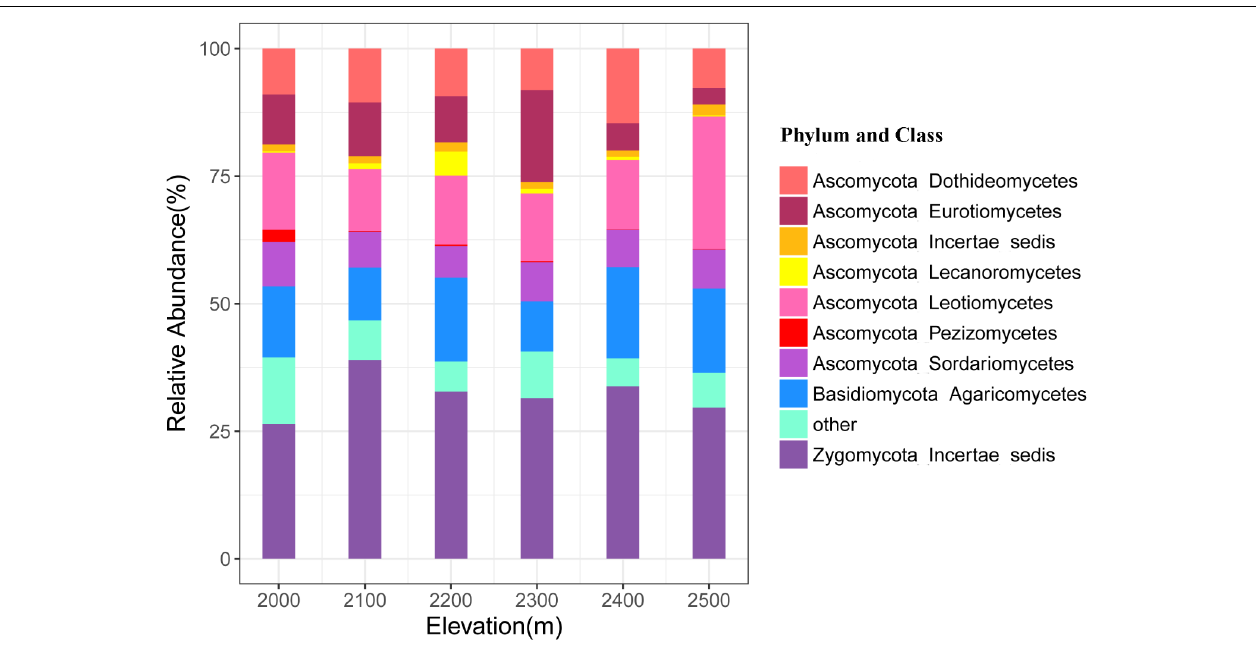
FIGURE 2 | Relative abundances of the dominant fungal phyla and classes in soils at different elevations. The phylum and classes with relative abundances of < 1% were assigned to “other.”